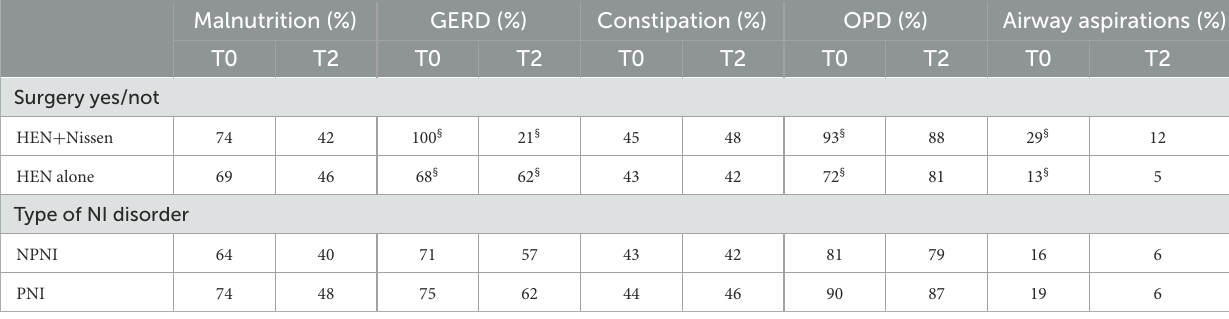
TABLE 5 Prevalence of clinical outcomes according to surgery and type of NI. Malnutrition (%) GERD (%) Constipation